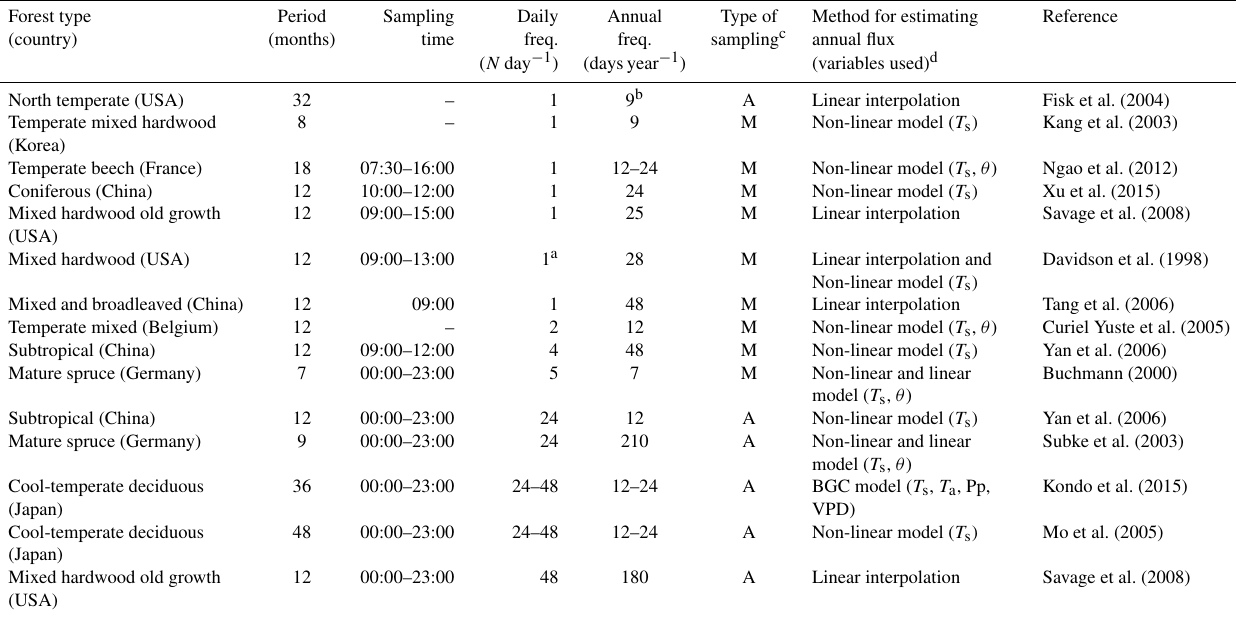
Table 1. Sampling schemes of studies where annual R s was estimated in humid forests. Forest